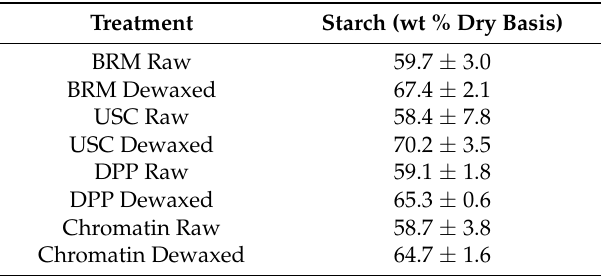
Table 3. Starch contents of raw and dewaxed